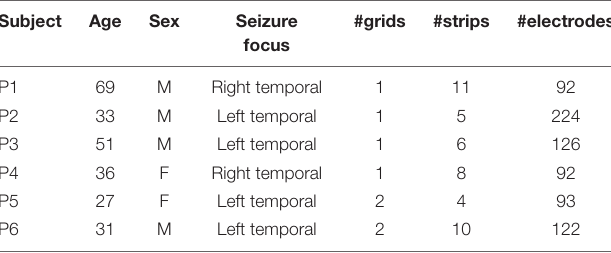
TABLE 1 | Clinical profiles of